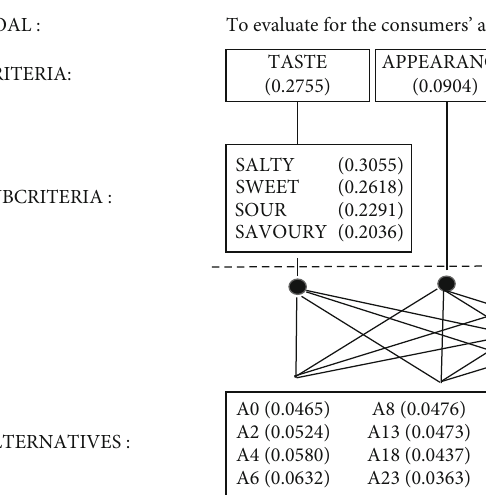
Figure 3: Hierarchy of criteria to evaluate for the consumers ’ acceptability of recipe A. The values presented the score of each criterion and alternatives. A means recipe A. The number after A means incubation time. Table 4: The score of each criterion for recipe